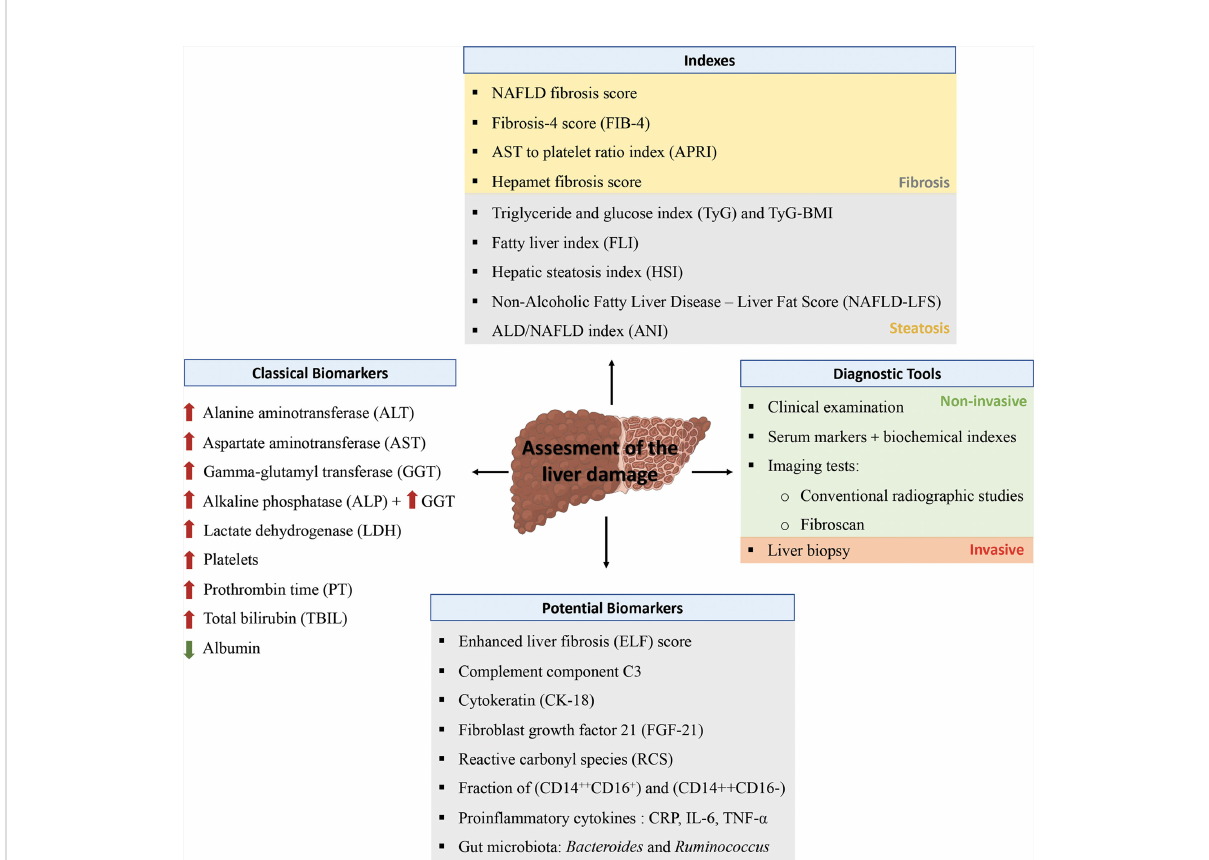
FIGURE 1 Assessment of liver disease. Different tools have been established for the diagnosis of liver disease in the clinical practice implying non-invasive (clinical examination and imaging test) and invasive techniques (liver biopsy). For screening method a number of scores based on analytical, clinical and anthropometric data are available to detect the risk of suffering liver fi brosis or steatosis. In this sense the alterations in various serum markers can evidence an alteration in the liver including liver enzymes, platelets, prothrombin, bilirubin or albumin. Finally, the latest studies point out to novel potential biomarkers that are associated with liver